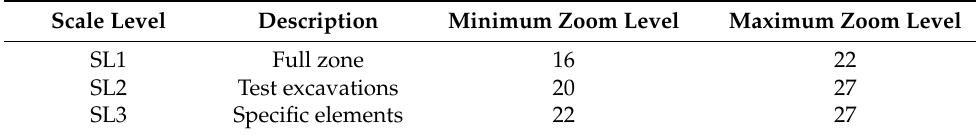
Table 2. Relationship between scale levels and web-mapping zoom levels.